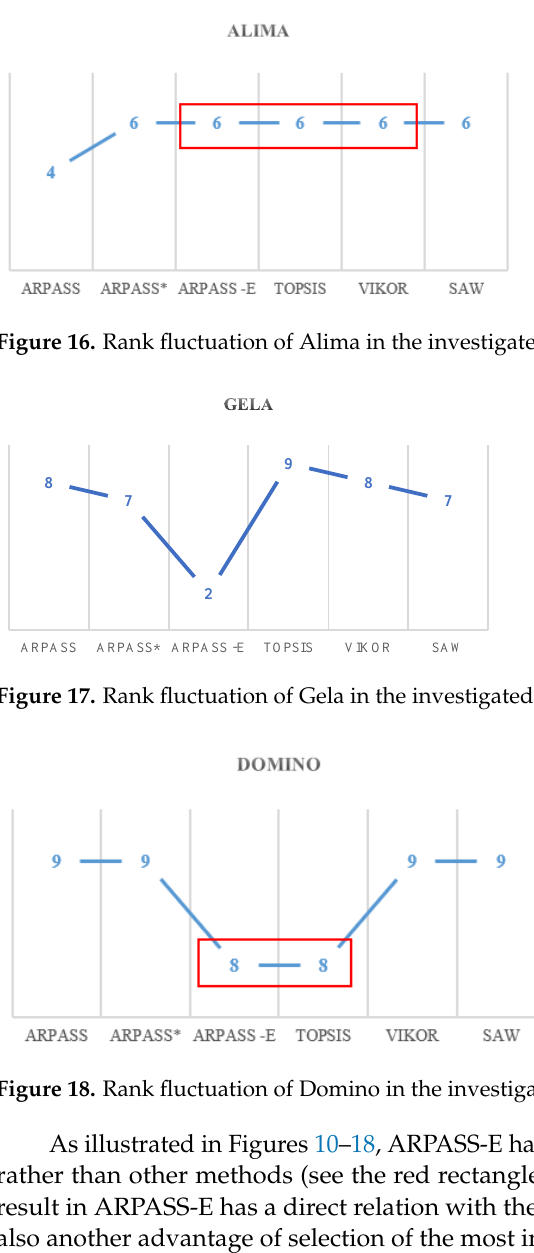
Figure 15. Rank fluctuation of Sabbah in the investigated MCDM methods.